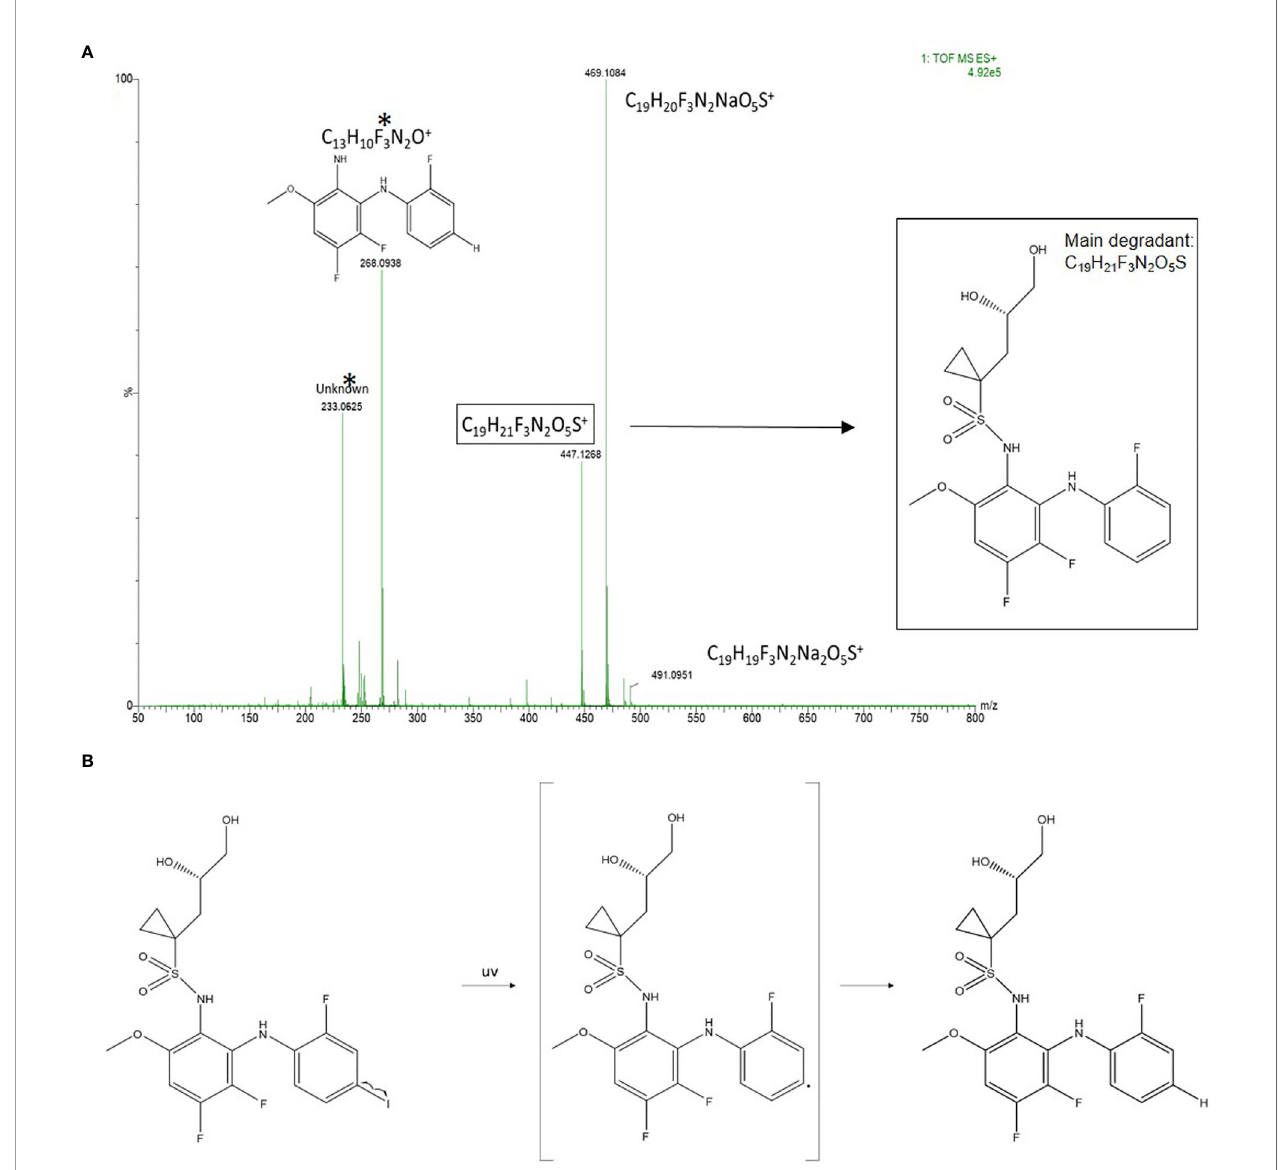
FIGURE 2 | Identi fi cation of the main degradant from the VIS light treated samples at t 7 . (A) MS-spectra of the refametinib degradant (RRT to refametinib = 0.8). * The peaks with an m/z of 268.0938 and 233.0625 are assigned as potential daughter molecules from the degradant after insource fragmentation. (B) The proposed chemical degradation of refametinib to C 19 H 21 F 3 N 2 O 5 S after